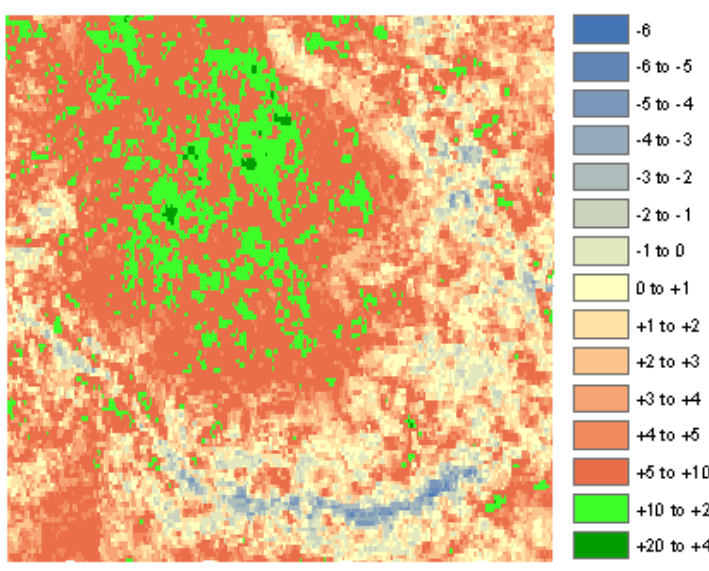
Figure 4a. Difference between ASTER v2 and OSGB heights in Wicken area. (Green pixels are those with discrepancies > 3 x